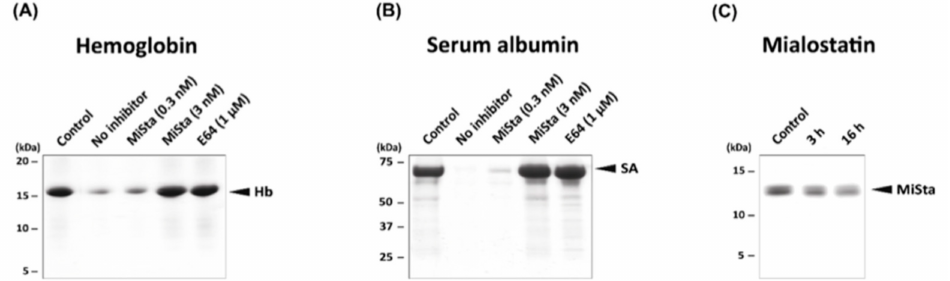
Figure 4. Blood protein digestion with tick gut proteases is inhibited by mialostatin. Hemoglobin ( A ) and serum albumin ( B ) were digested in vitro with I. ricinus gut tissue extracts in the presence and absence of mialostatin. Blood protein substrate (5 µ g of hemoglobin or 10 µ g of serum albumin) was incubated with 0.4 µ g gut tissue extract of cysteine proteases at pH 3.6 for 16 h. The extract was pre-incubated with mialostatin (MiSta) or the general cysteine protease inhibitor E-64 at the indicated concentrations prior to initiation of digestion. The digests were subjected to Tricine-SDS-PAGE ( A ) or Laemmli-SDS-PAGE ( B ) and visualized by protein staining. The hemoglobin (Hb) and serum albumin (SA) substrates are marked; the non-digested control is indicated. ( C ) Proteolytic stability of mialostatin in the gut tissue extract. Mialostatin (5 µ g) was incubated with 0.4 µ g gut extract protein under the same conditions as in ( A , B ), subjected to Tricine-SDS-PAGE, and visualized by protein staining. Mialostatin (MiSta) is marked; the non-digested control is